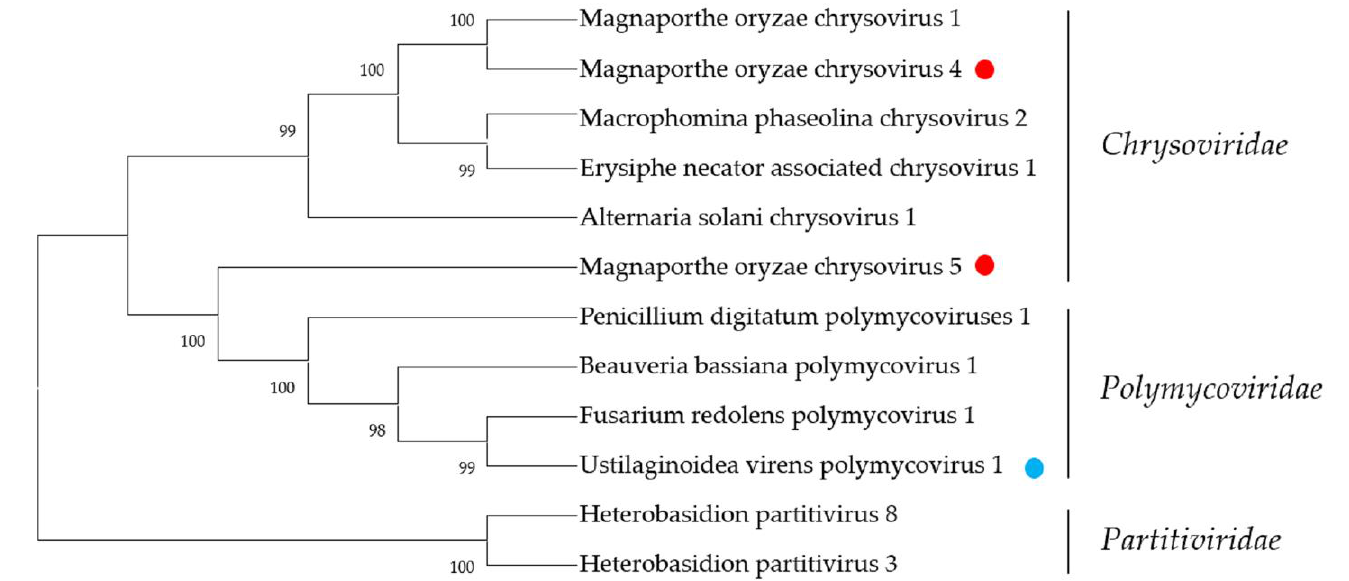
Figure 7. Phylogenetic analysis of viruses in the families Chrysoviridae and Polymycoviridae . Neighbor-joining-method phylogenetic tree based on the core RdRP motifs of putative viruses in the family Chrysoviridae and Polymycoviridae , other related viruses, and representatives of the two families. Viruses marked with red color are found in P. oryzae and blue color in U. virens . The viruses without a color annotation are the representatives of the known species of each viral family.